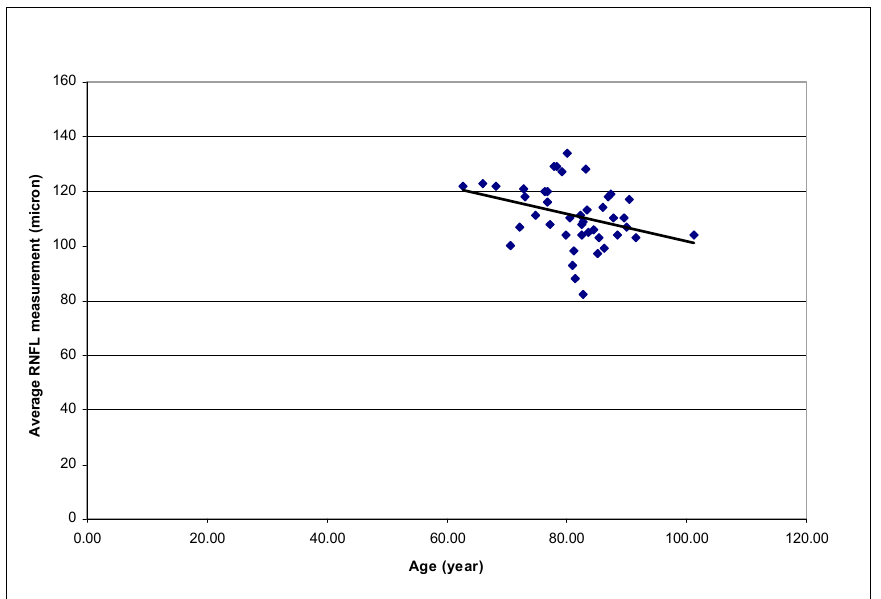
Figure 4. Correlation between Average RNFL measurements by Spectral-domain OCT and patients’ age. ( p = 0.033, R 2 = 0.106; OCT: Optical coherence tomography; AMD: Age-related macular degeneration; RNFL: Retinal nerve fiber layer.).